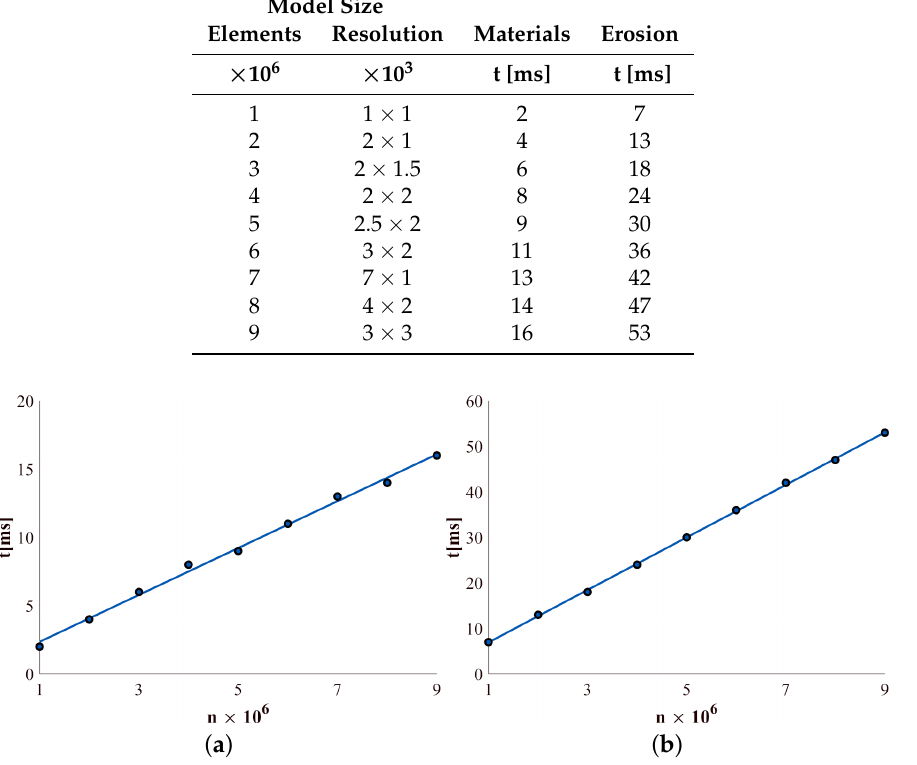
Figure 23. Computational efficiency of the proposed techniques. ( a ) Material classification. ( b ) Model